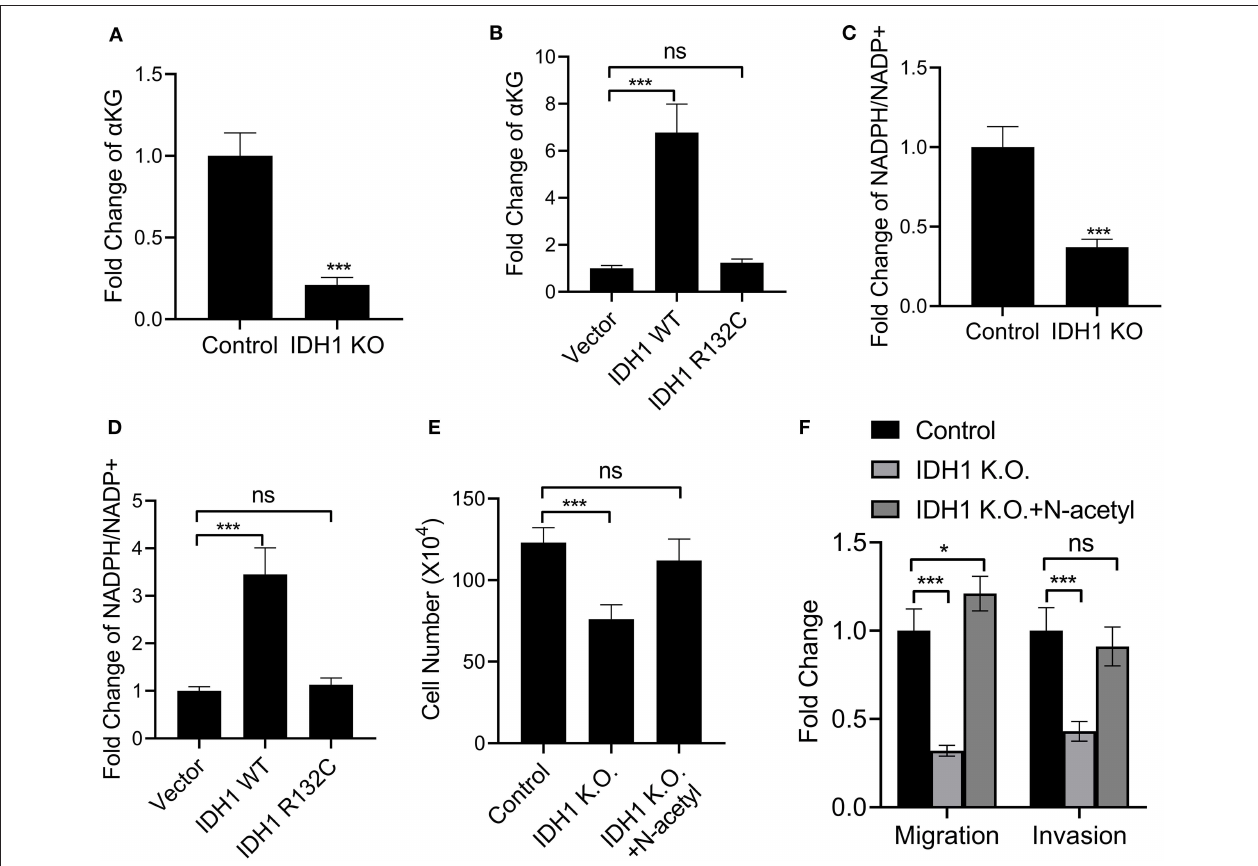
FIGURE 4 | IDH1 mutation reduced NADPH and α -KG levels. (A,B) ELISA was used to determine the levels of α -KG in REB cells, IDH1 KO REB cells, IDH1 KO REB cells transfected with vector, wildtype IDH1 or IDH1 R132C mutation plasmid. (C,D) ELISA was used to determine the levels of NADPH in REB cells, IDH1 KO REB cells, IDH1 KO REB cells transfected with vector, wildtype IDH1 or IDH1 R132C mutation plasmid. (E) Cell count assay were used to determine the cell viabilities of REB cells or REB IDH1K.O. cells treated with or without N-acetyl cysteine. (F) Cell migration and invasion assay of the REB cells or REB IDH1K.O. cells treated with or without N-acetyl cysteine. Data were shown as mean ± S.D. * P < 0.05, *** P < 0.001; ns indicates no